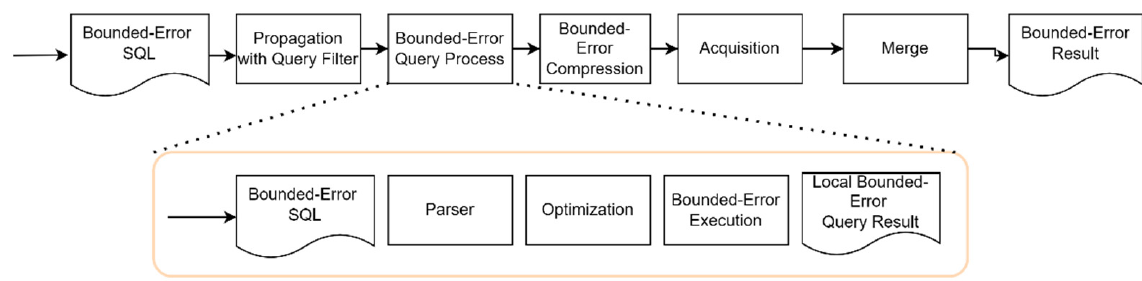
Figure 2. System architecture of an edge-computing OBEQ for IoT (S1, S2 are SNs, E1–E3 are EDs).